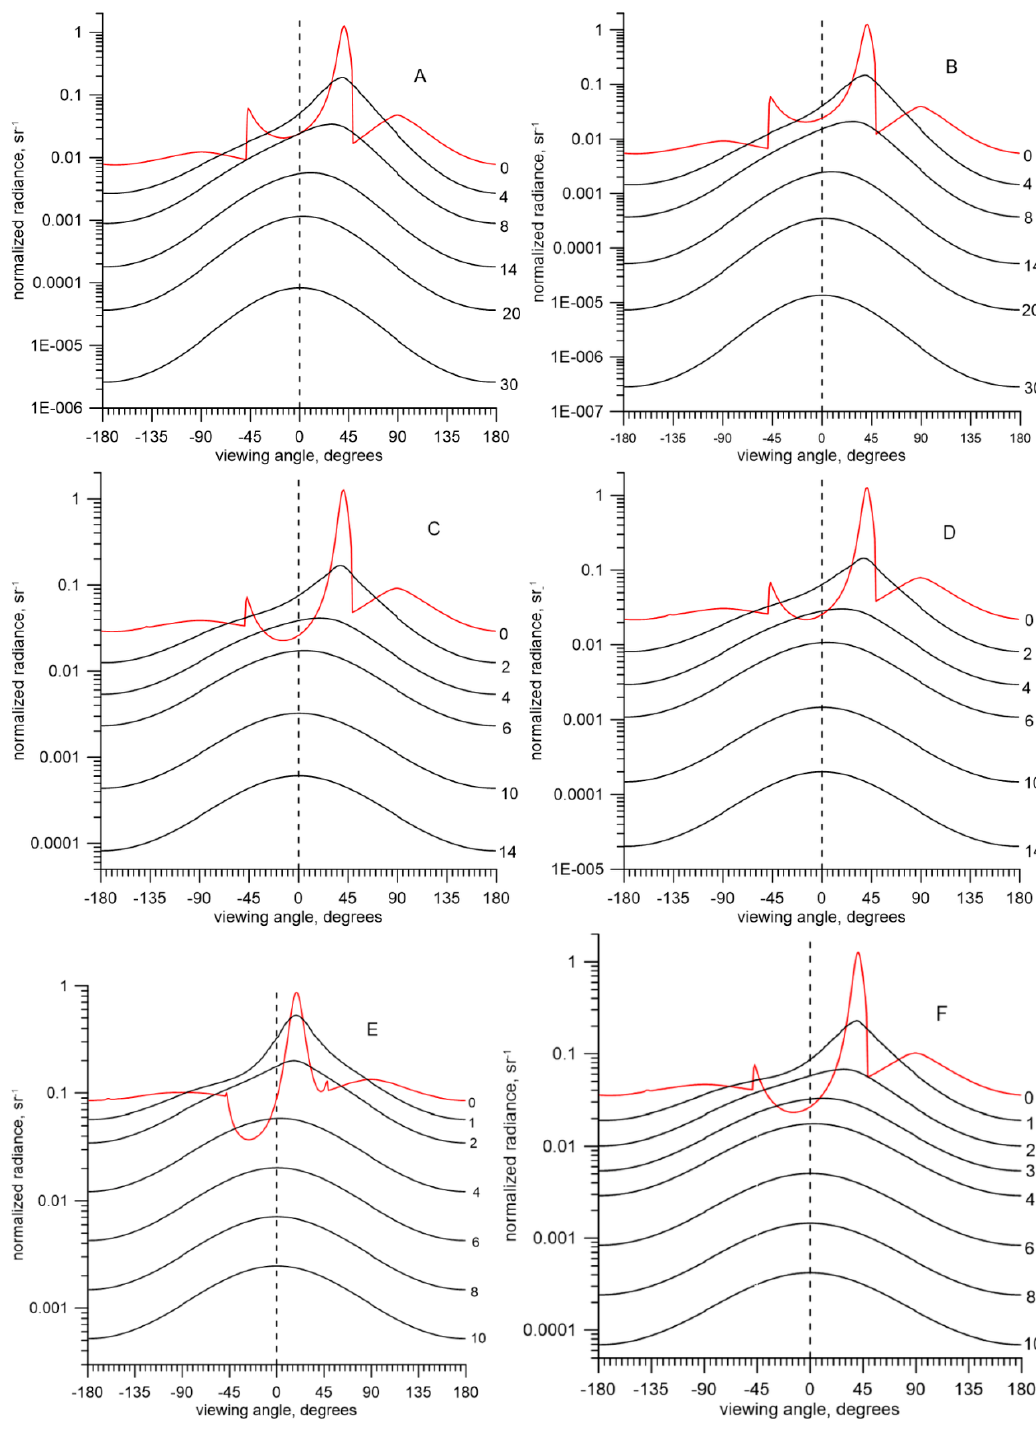
Figure 5. Barents Sea. The same as in Figure 4. ( A ) N coc = 0 cell/L, a (400) = 0.18 m − 1 ; further respectively. ( B ) 0, 0.53; ( C ) 5 × 10 6 , 0.18; ( D ) 5 × 10 6 , 0.53; ( E ) 10 7 , 0.18; ( F ) 10 7 , 0.53; θ 0 = 60°.